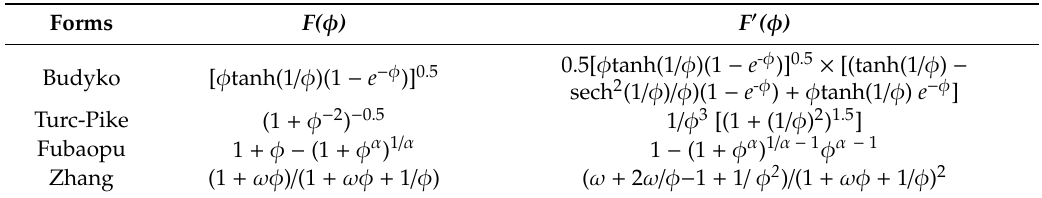
Table 1. Four commonly used forms of F( φ ) and F (cid:48) ( φ ) based on the Budyko hypothesis. Forms F( φ )